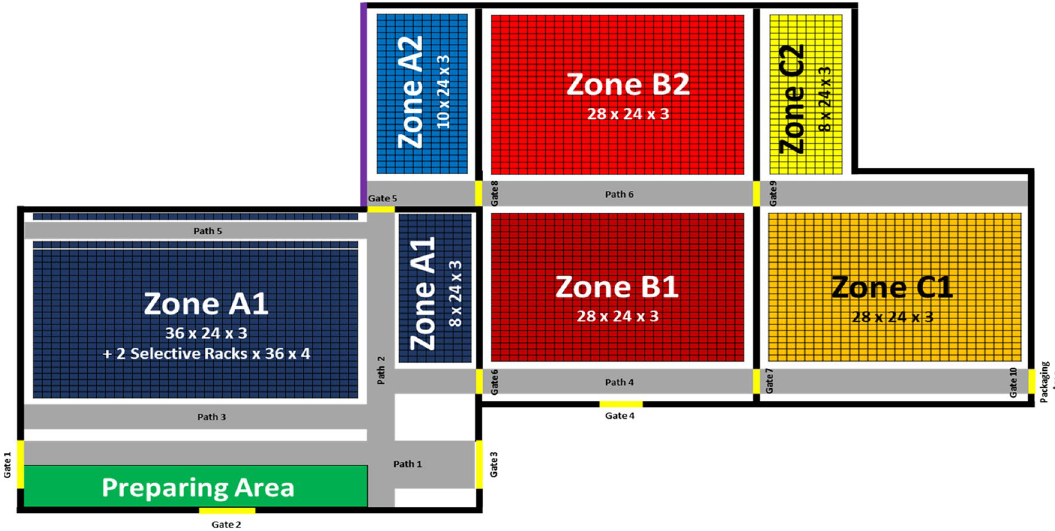
Fig. 1 Current layout of the retail